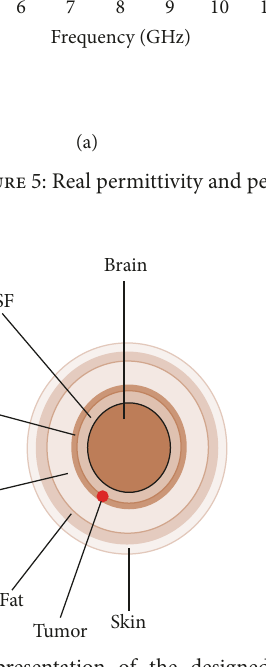
Figure 6: Schematic representation of the designed spherical cancerous head phantom.